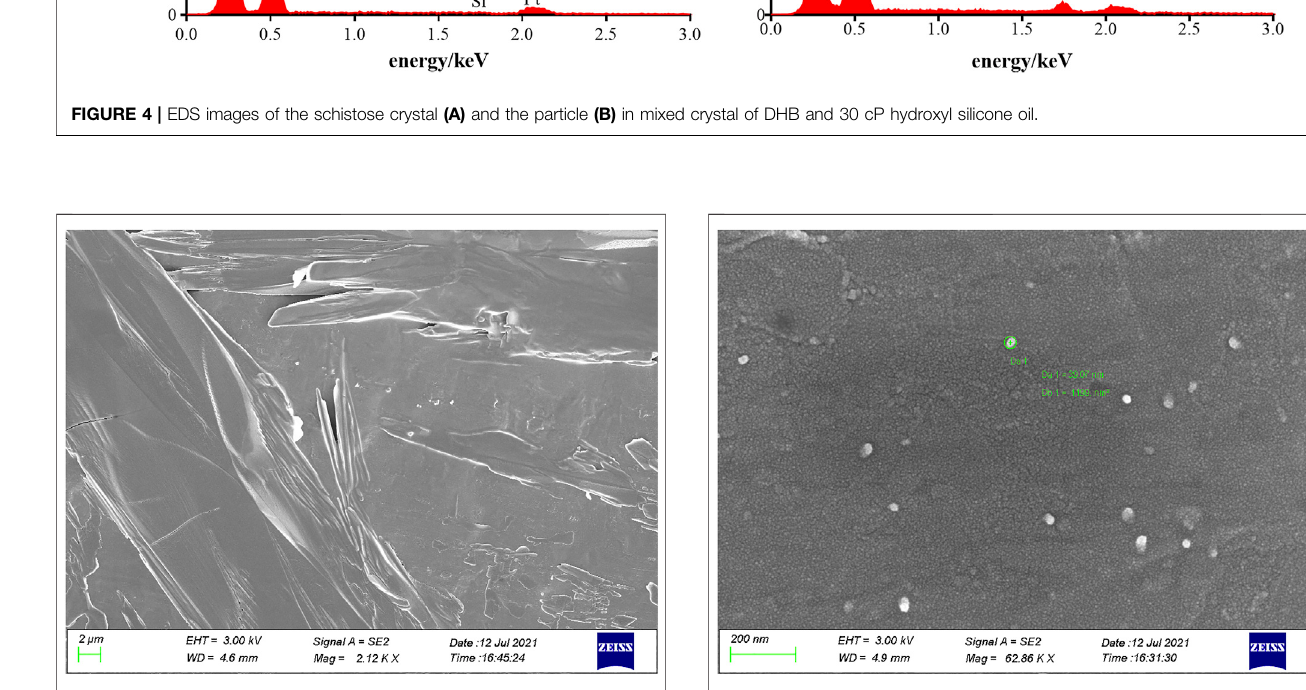
FIGURE 6 | SEM image (at the 200 nm level) of the mixed crystal of the pyridine-modi fi ed DHB and 30 cP hydroxyl silicone